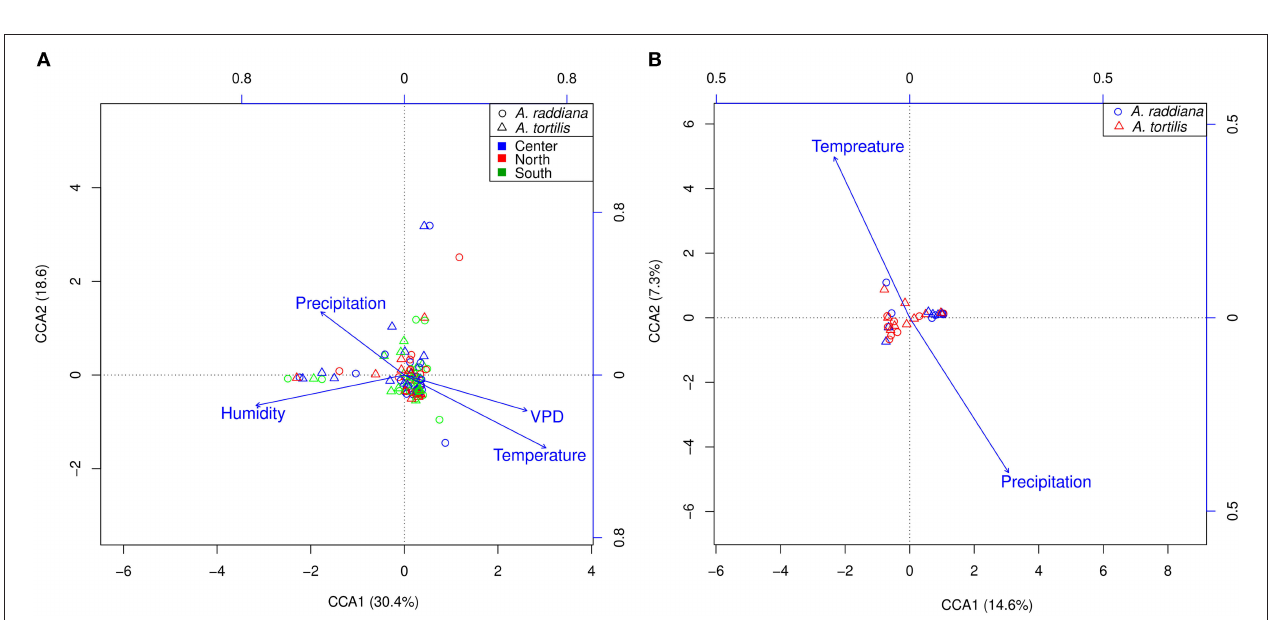
FIGURE 5 | CCA ordination illustrating (A) epiphytic bacterial community at north (red), south (green), and center (blue) canopy sides and (B) endophytic bacterial communities, for A. raddiana (blue circles) and A. tortilis (red triangles) with significant abiotic factors affecting the bacterial